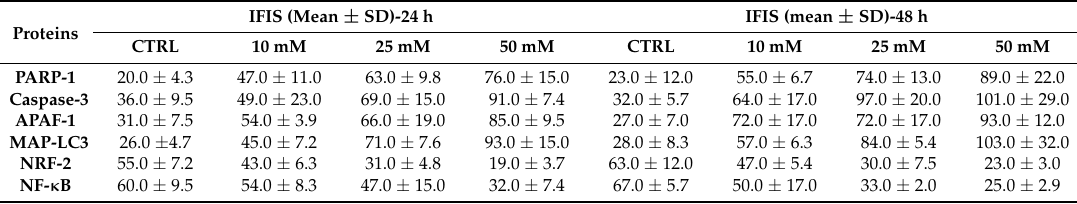
Table 1. Evaluation of immunostaining intensity (Immunofluorescence Intensity Score: IFIS). IFIS (Mean ± SD)-24 Proteins